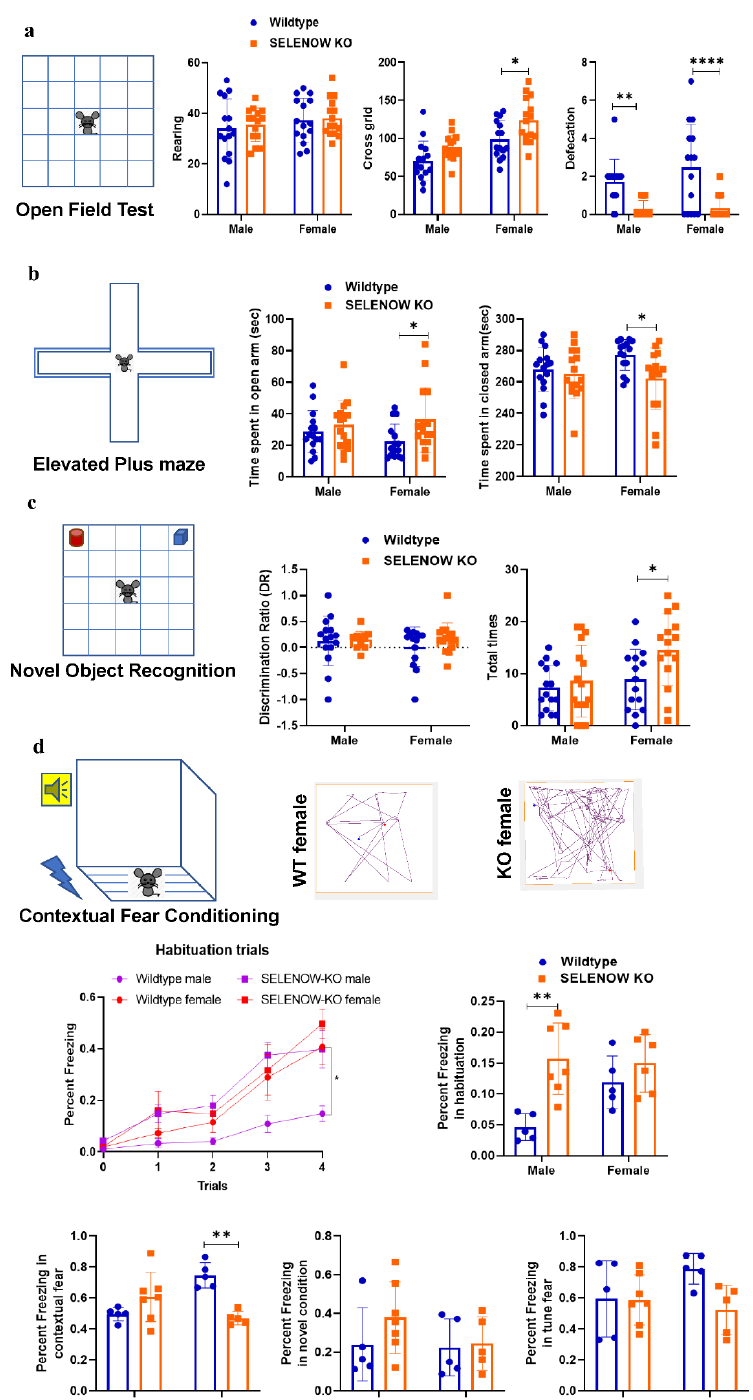
Figure 2. Behavioral test results for the assessment of locomotion ability, anxiety, and learning and memory in WT and KO mice. ( a ) Locomotion ability and anxiety of the 6 month old WT and KO mice evaluated by the crossing grid numbers, rearing and defecation times in the open field test ( n